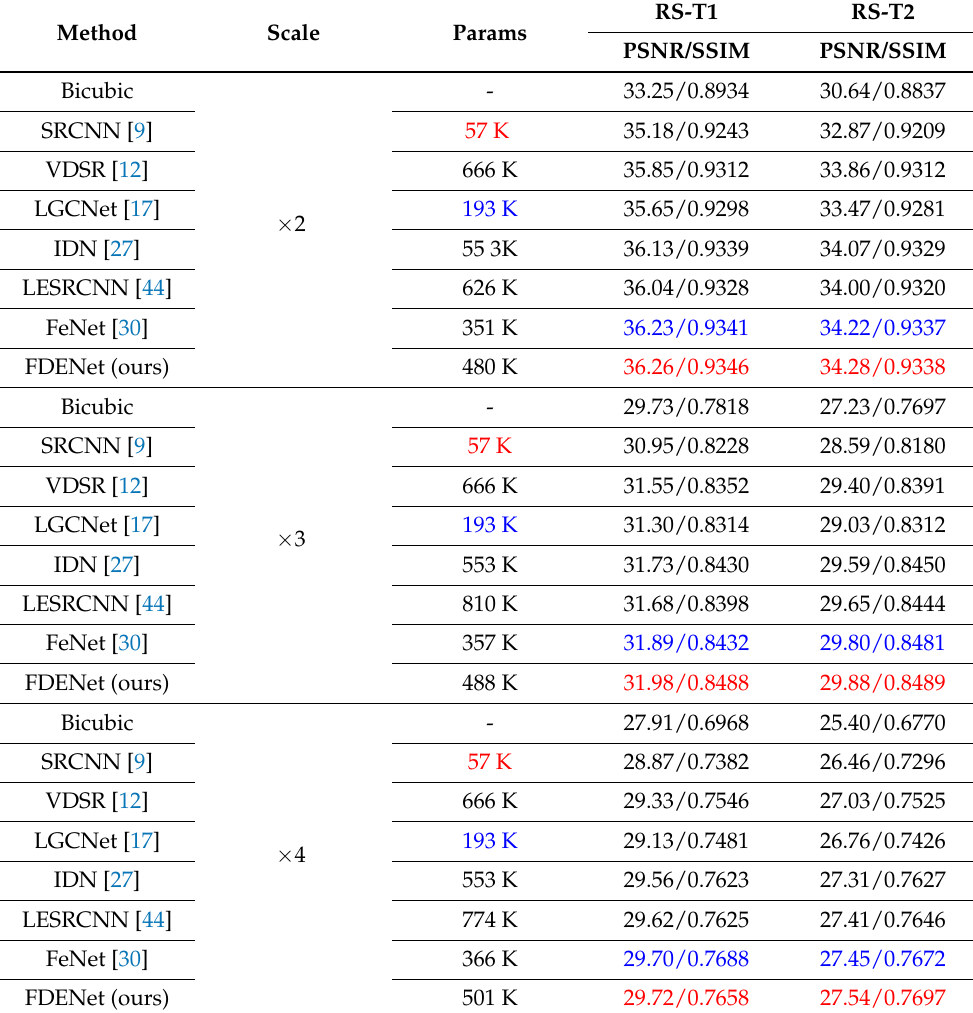
Table 1. Quantitative evaluation results of remote sensing data sets. “Params” represents the model parameter quantity; the best and second best results are red and blue, respectively. “-” indicates that no result is